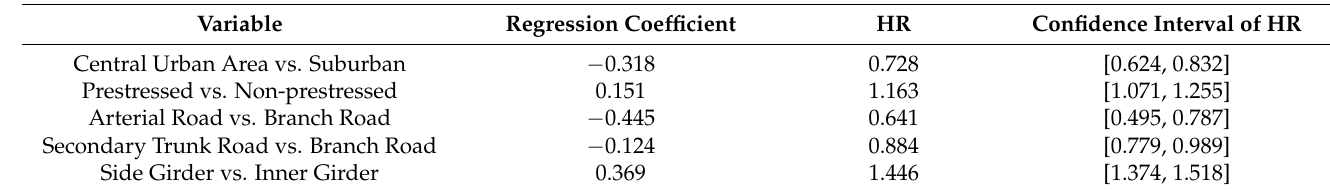
Table 6. Regression coefficient, HR, and confidence interval of HR (95%) of Cox model with different